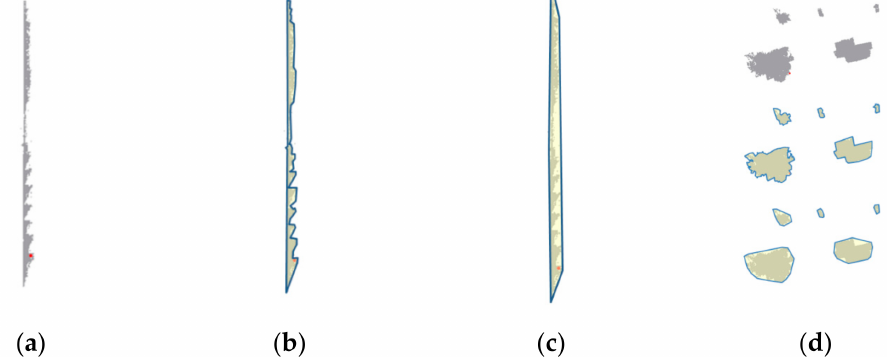
Figure 7. Limitation of the horizontal hollow ratio in single-wall facade detection. The left three figures show that the projected points of a single-wall facade in ( a ), the corresponding projection in ( b ) and the convex hull in ( c ) have similar areas. Thus, the horizontal hollow ratio of the single-wall facade in ( a ) is similar to that of the stem and canopy projections in ( d